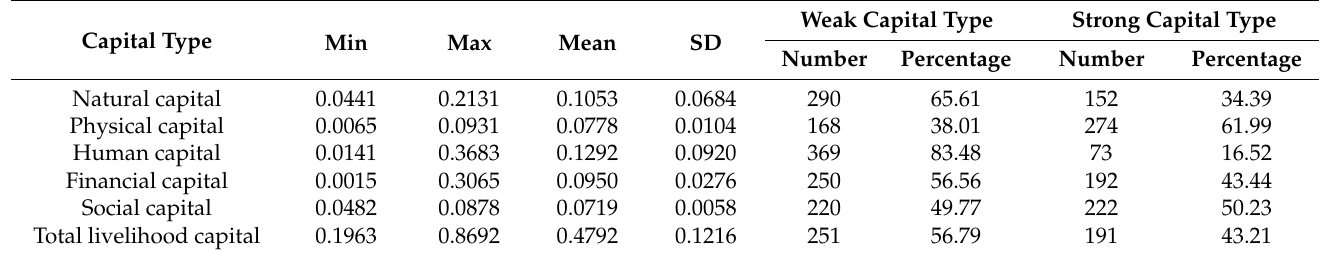
Table 3. Evaluation of total level and classification levels of rural households’ livelihood capital.